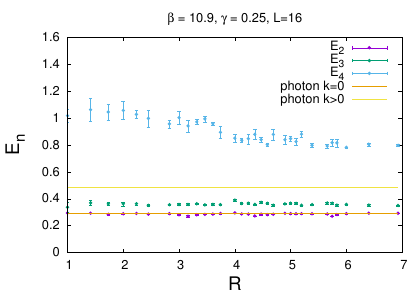
Figure 7. Energies E 2 , 3 , 4 ( R ), but this time at γ = 0 . 25, with β = 10 . 9 and lattice volume 16 3 × 36. The lower and upper solid lines represent the energies of a static massive photon, and a photon of minimal momentum for this periodic volume